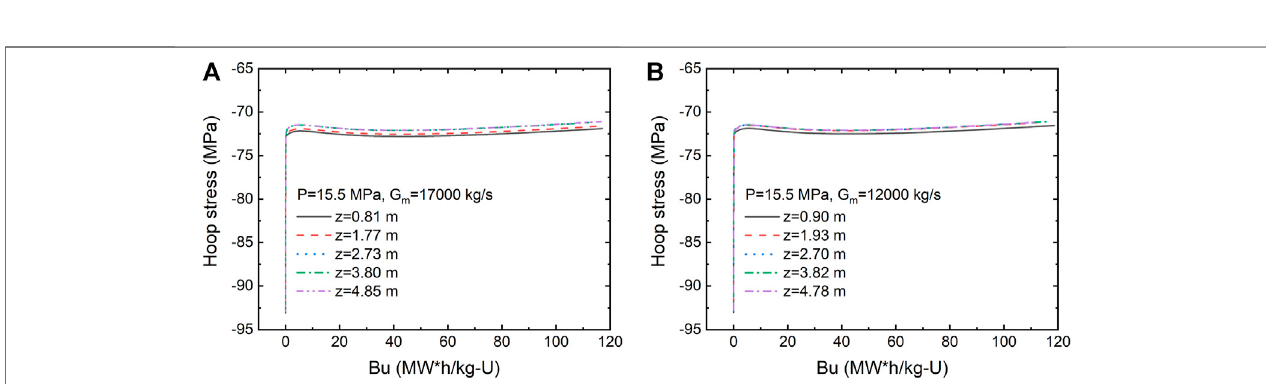
FIGURE 12 | Evolution of hoop stress of UO 2 fuel with burnup under the coolant pressure of 15.5 MPa and two different mass fl uxes. Calculated results are compared at some similar positions in both cases.